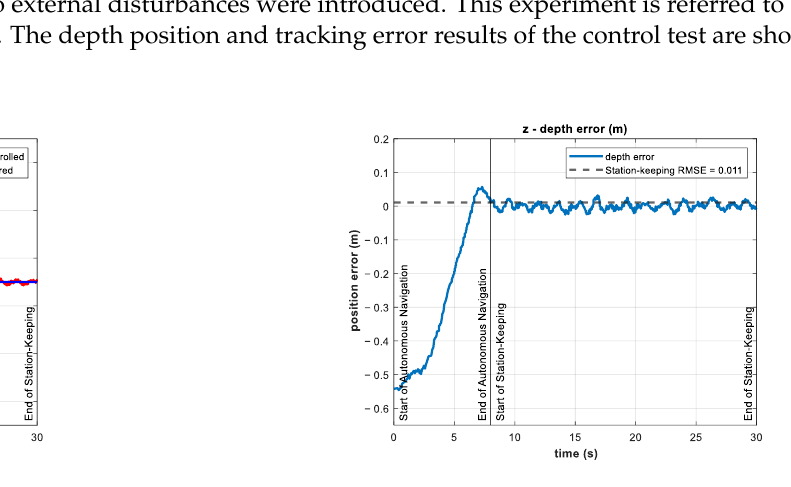
Figure 10. Depth ( left ) and tracking error ( right ) results of the control test. No external disturbances were introduced.